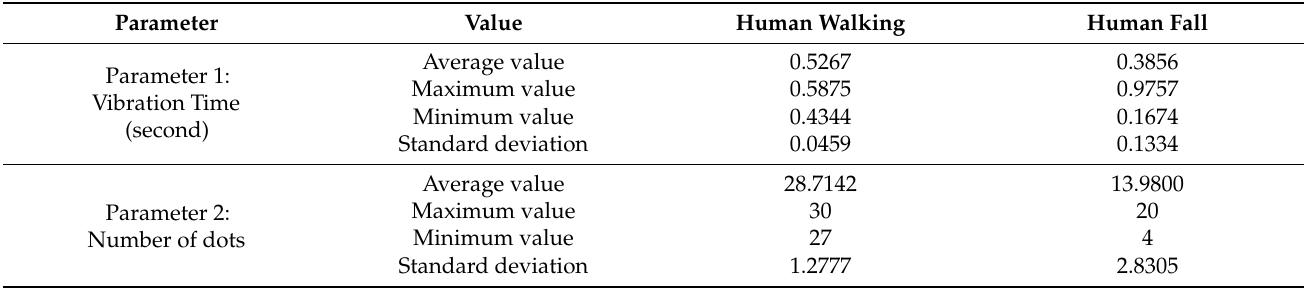
Table 3. Values of the selected parameters in different data